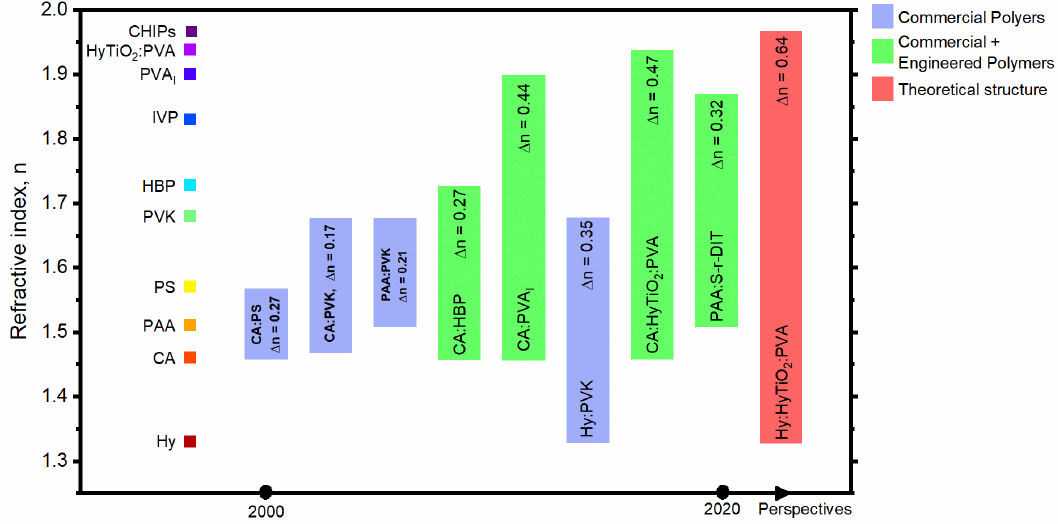
Figure 2. Refractive index values at 550 nm for commercial polymers [95,96,110,168] and for engineered polymeric systems employed for the fabrication of DBRs [109,134,136,138,169,170]. Notice that the value for CHIPs is reported in [136,169] at 600 nm. The value at 550 nm is therefore expected to be larger. Bars represent the dielectric contrast achieved in published DBR structures for commercial polymers (blue bars) and coupling commercial polymers with engineered polymeric media (green bars). The red bar represents the maximum theoretical dielectric contrast achievable within a polymeric system. The dielectric contrast bars are ordered from left to right by publication date. HBP: hyperbranched poly(vinyl sulfide); Hy: perfluorinated polymers.